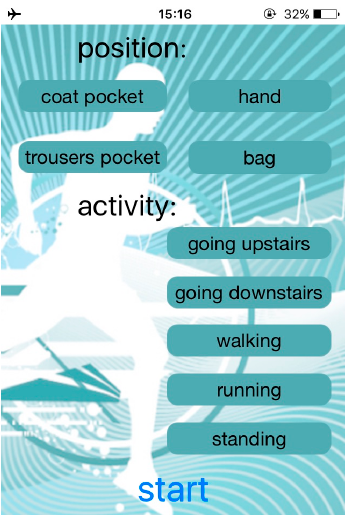
Figure 5. Data collection.